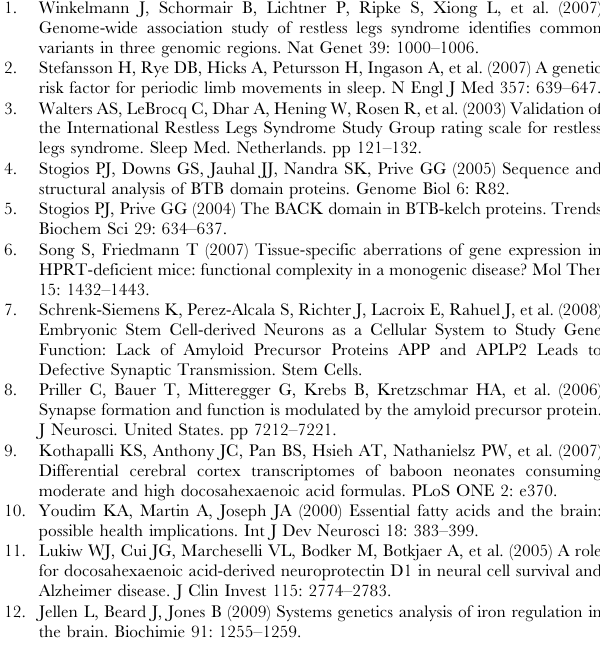
(TIF) Figure S3 Western blot analyses of synaptic proteins from hippocampal synaptosome fractions. Representative Western blot images and quantitative analysis of SNAP-25 ( A ), syntaxin ( B ), synaptotagmin ( C ), synaptophysin ( D ), and synapto- brevin ( E ). Bars represent means 6 SEM. (TIF) Table S1 Primers located in the sixth intron of the Btbd9 gene. Length is the number of nucleotides. Locations are relative to the start of Intron 6 (intron between Exons 6 and 7). (XLSX) Table S2 Primers located in the b -geo gene trap vector. Length is the number of nucleotides.